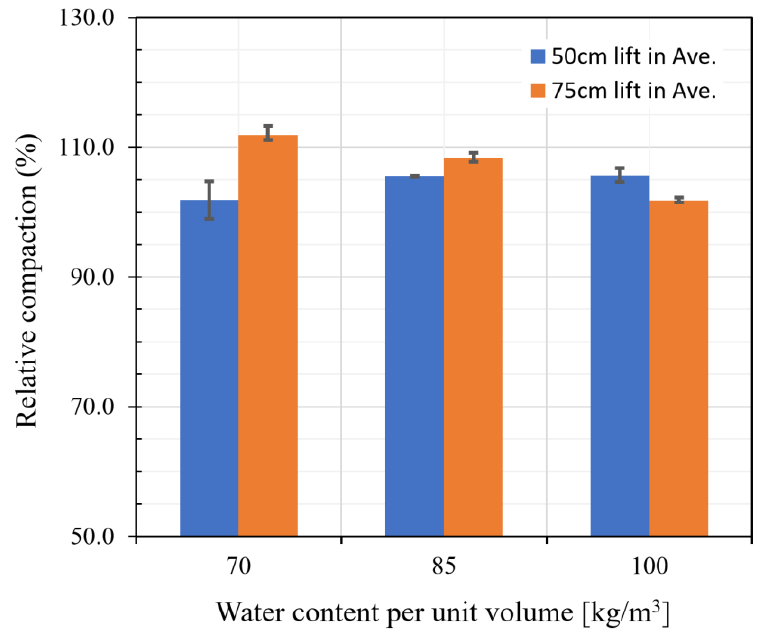
Figure 10. Relative compaction of field-constructed hardfill.